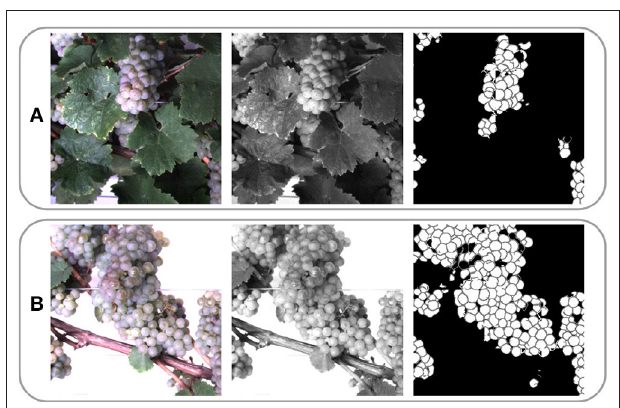
FIGURE 4 | Example patches extracted from images of (A) the occluded and (B) non-occluded domain. One row shows the same patch in RGB, grayscale, and berry mask format. One column represents a patch pair { x occ , x non } .